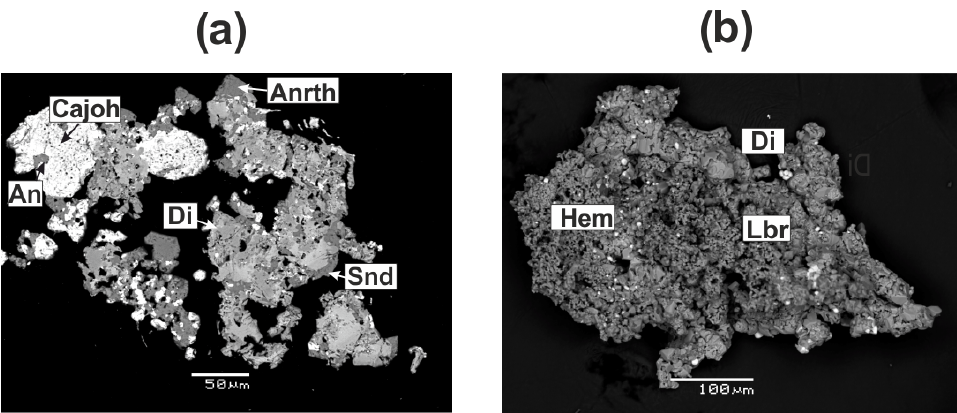
Figure 5. Plagioclases from the Arsenatnaya fumarole: inclusion of anorthite (An) in aggregate of calciojohillerite (Cajoh) associated with anorthoclase (Anrth), diopside (Di) and sanidine (Snd) (a) ; porous crust of labradorite (Lbr) with diopside and hematite (Hem) (b) . BSE